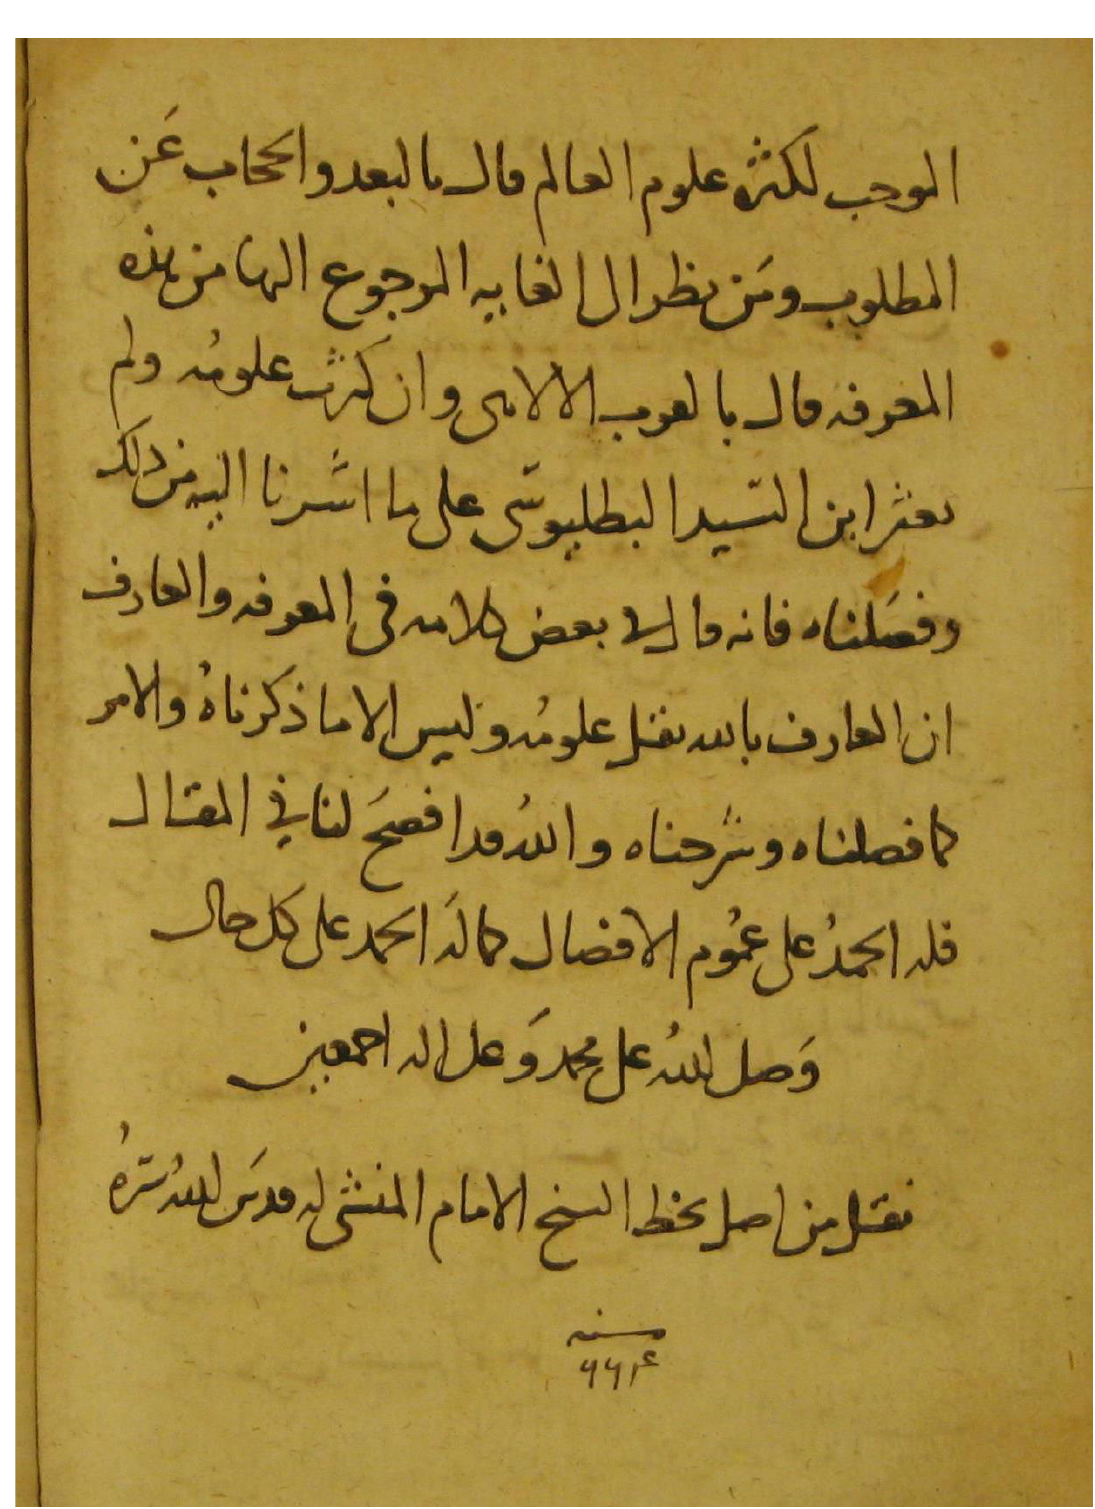
Figure A1. The colophon of the MS Manisa 1183, f.117b.